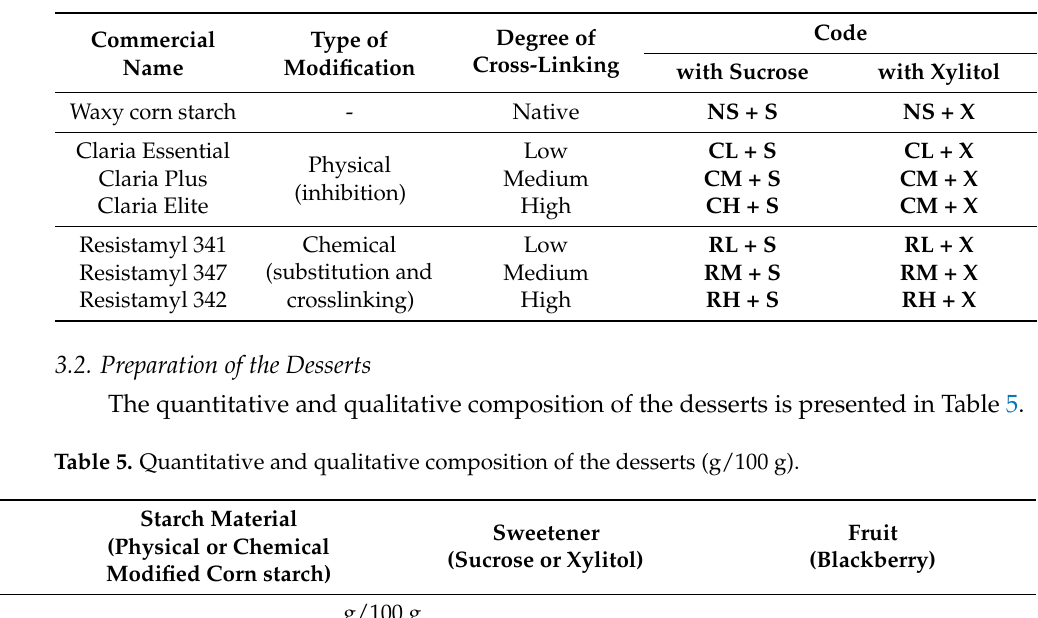
Table 4. Characteristics of modified corn starches and chemical composition of